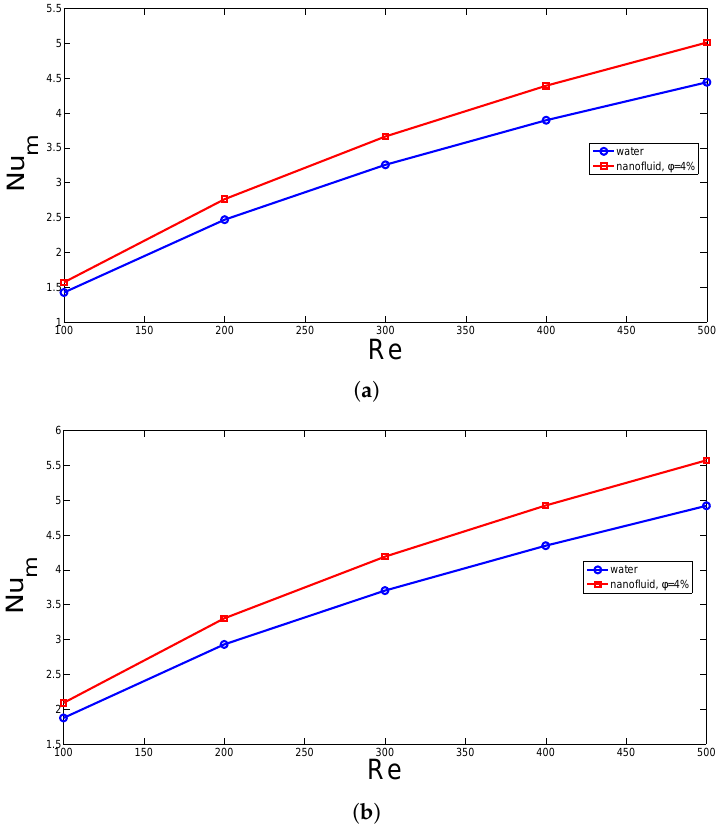
Figure 4. Effects of Reynolds number on the variation of the average Nusselt number for the upper walls of the horizontal and vertical channels with respect to change in Reynolds number (Ha = 1): Energies 2019 , 12 , 5 10 of 17 ( a ) W2, average Nusselt number variation; and ( b ) W4, average Nusselt number variation.